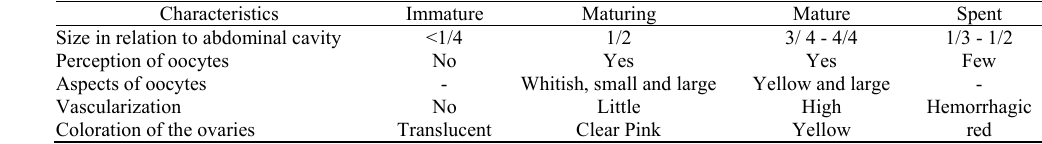
Table 4. Macroscopic description of the ovarian stages of female Plagioscion magdalenae .